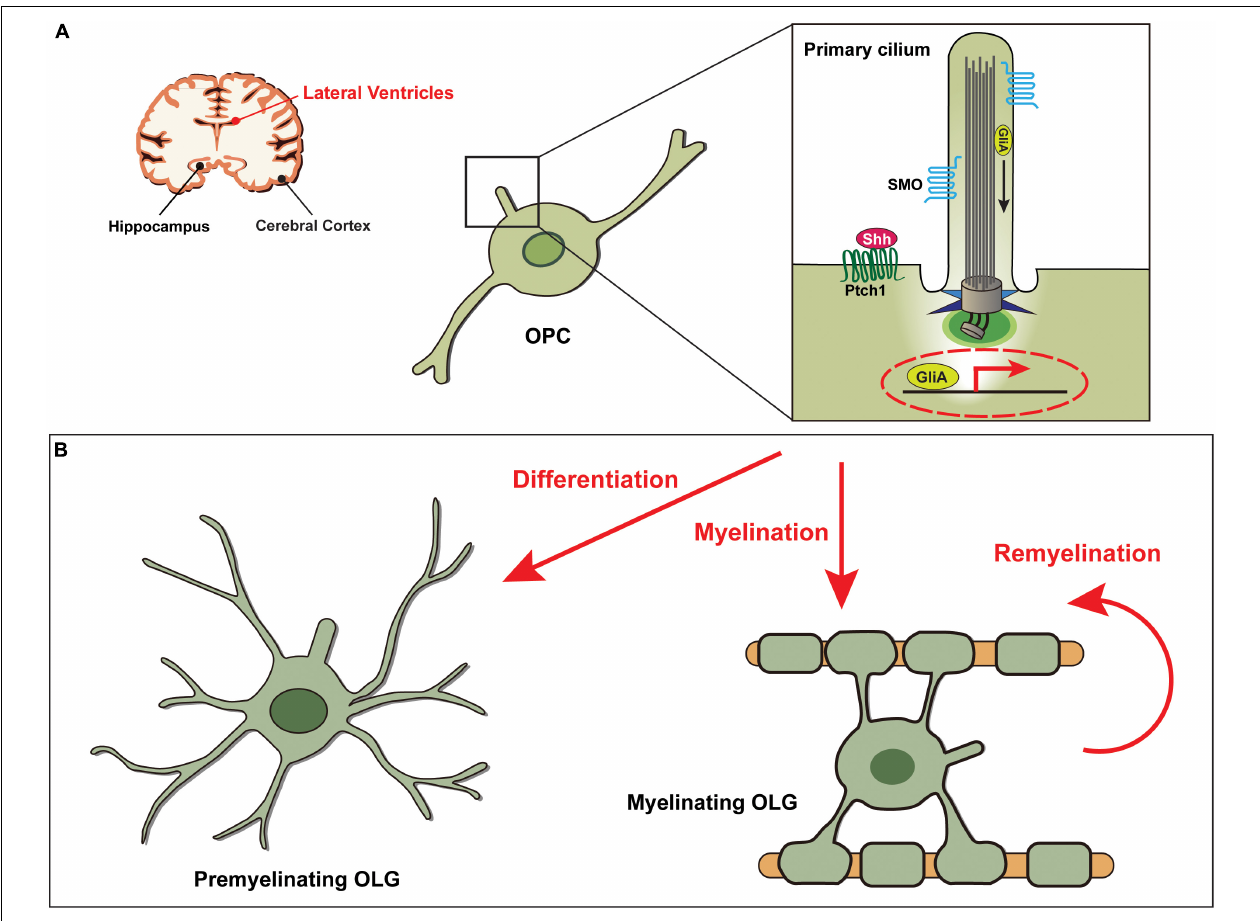
FIGURE 2 | Shh signaling through the primary cilia in OPCs is essential for the development of oligodendrocytes. (A) Diagram showing the primary cilia of oligodendrocyte progenitor cells (OPCs) associated with functions in the lateral ventricles. (B) Shh signaling is activated by binding of the Shh ligand to the Ptch1 receptor, leading to the release of SMO from Ptch1 and its translocation into the primary ciliary axoneme. GliA, the activator form of Gli, then induces transcription of Shh target genes, which are involved in differentiation of OPCs to oligodendrocytes (OLGs) and in (re)myelination of